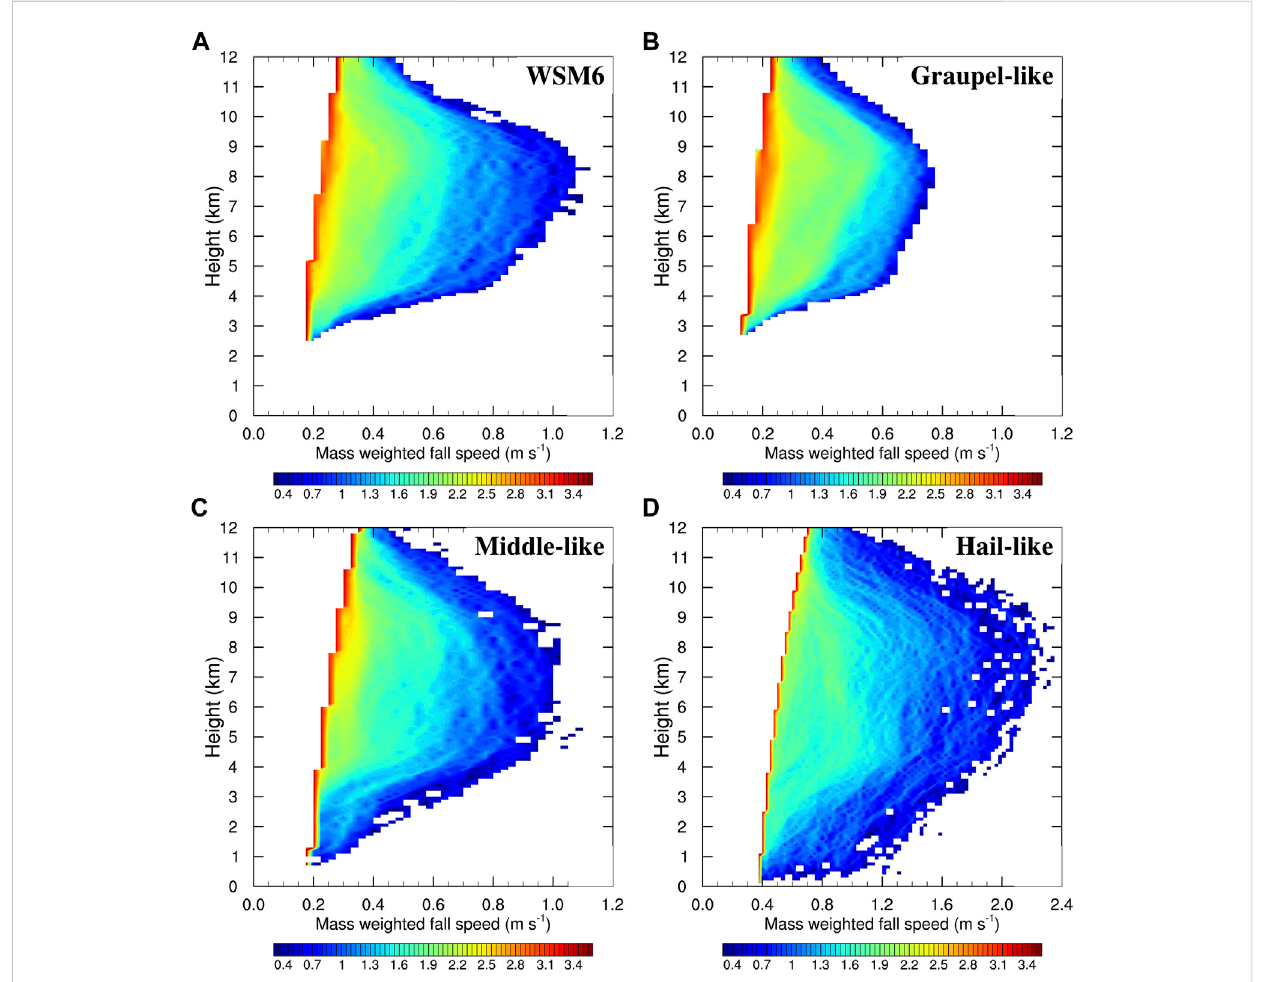
FIGURE 12 Same as in Figure 11, but for the mass weighted fall speed (m s − 1 ) of graupel particles in (A) WSM6, (B) WSM6-Graupel-Like, (C) WSM6-Middle-Like and (D) WSM6-Hail-Like